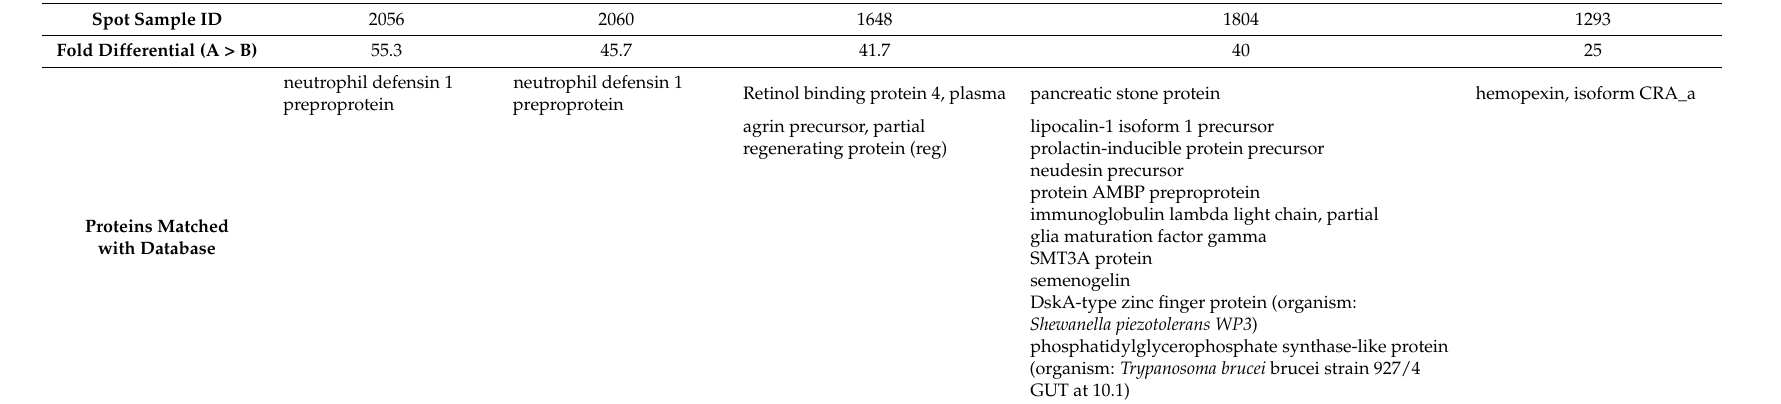
Table 2. Results of mass spectrometry analysis of top five differentially expressed spots.